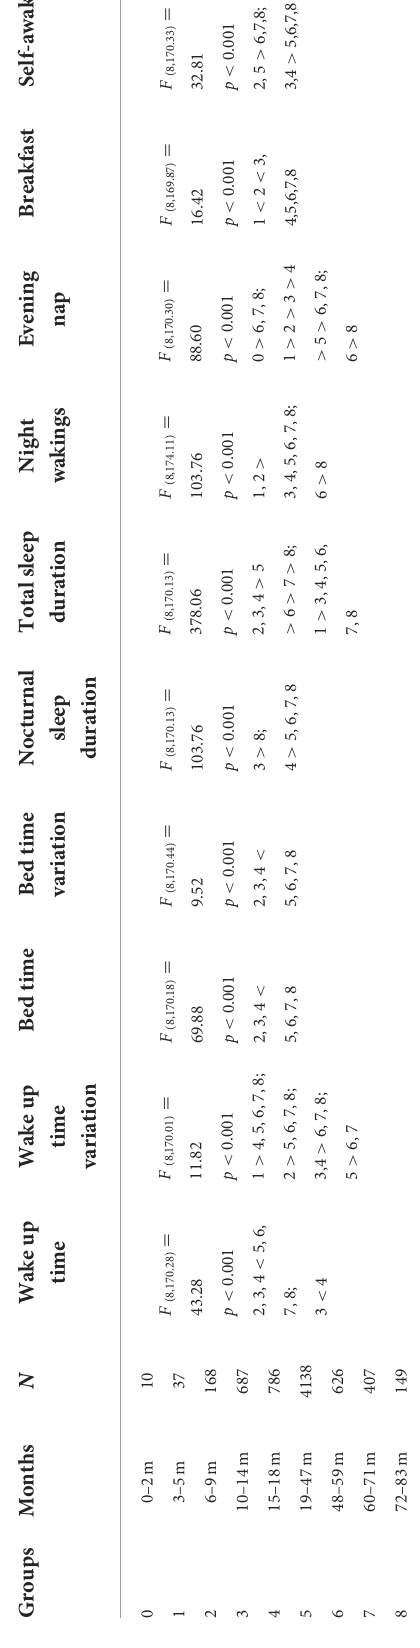
(Figure 7) tended to decrease with increasing age. Total